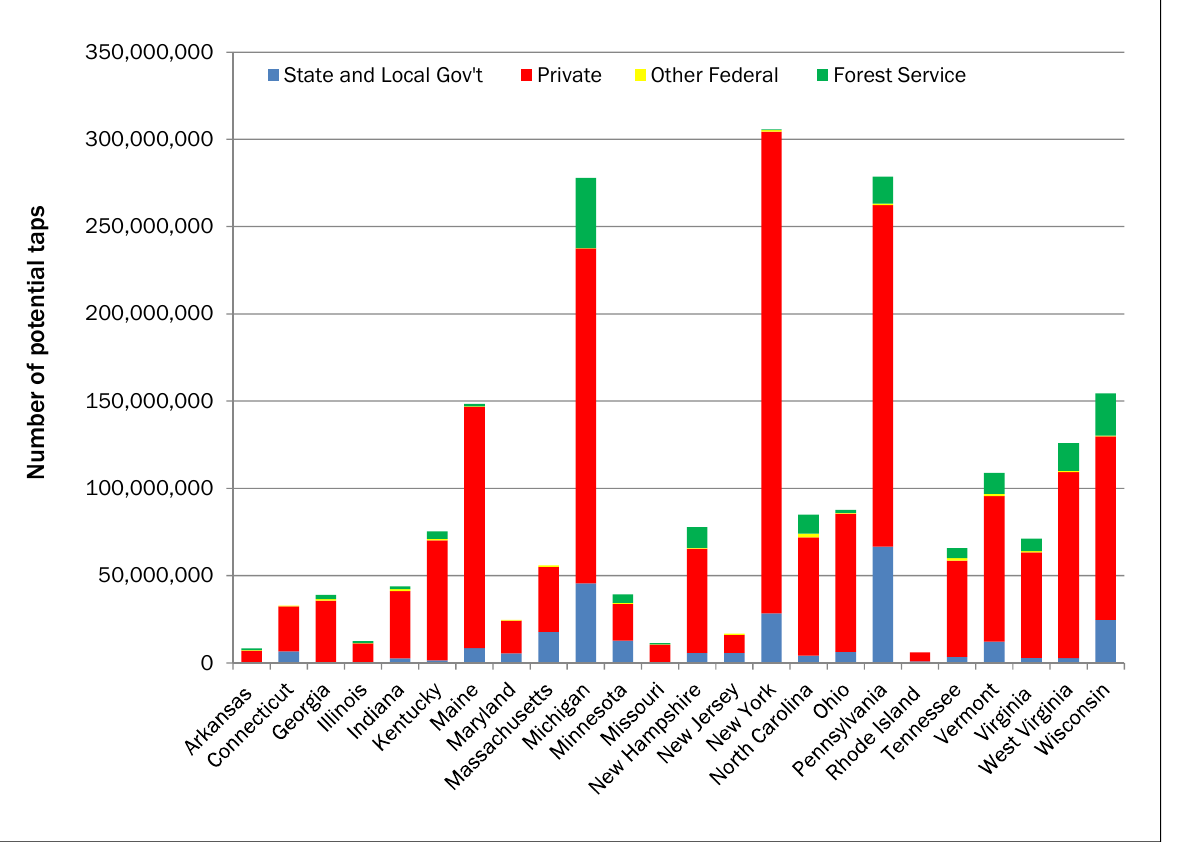
Figure 4. Number of Potential Red Maple Taps for 24 States by Ownership Status, 2011